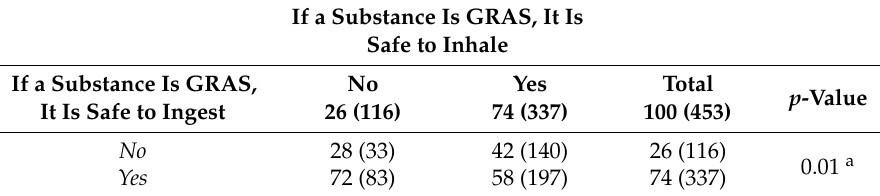
Table 2. Understanding of “generally recognized as safe” (GRAS) among people who consider flavorings to be GRAS- % ( n ). If a Substance Is GRAS, It